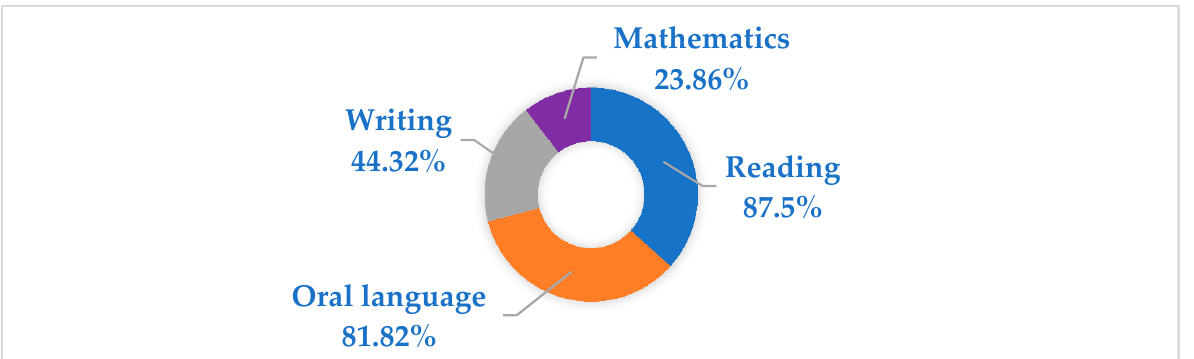
Figure 2. Basic instrumental skill most present in the apps.